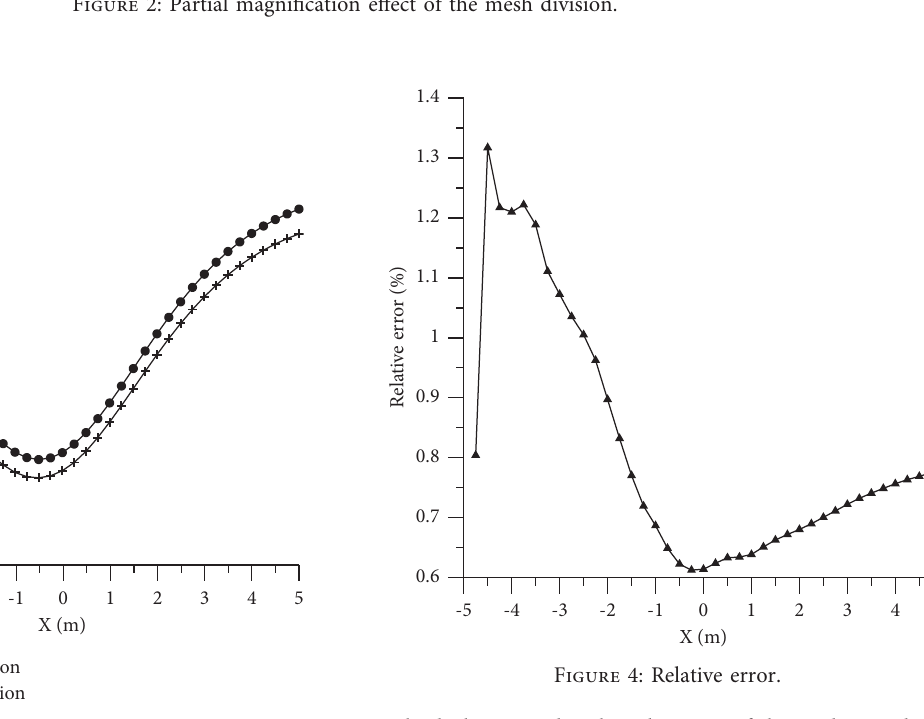
Figure 3: Comparison of analytical and numerical solutions of apparent resistivity of the underground spheroid.